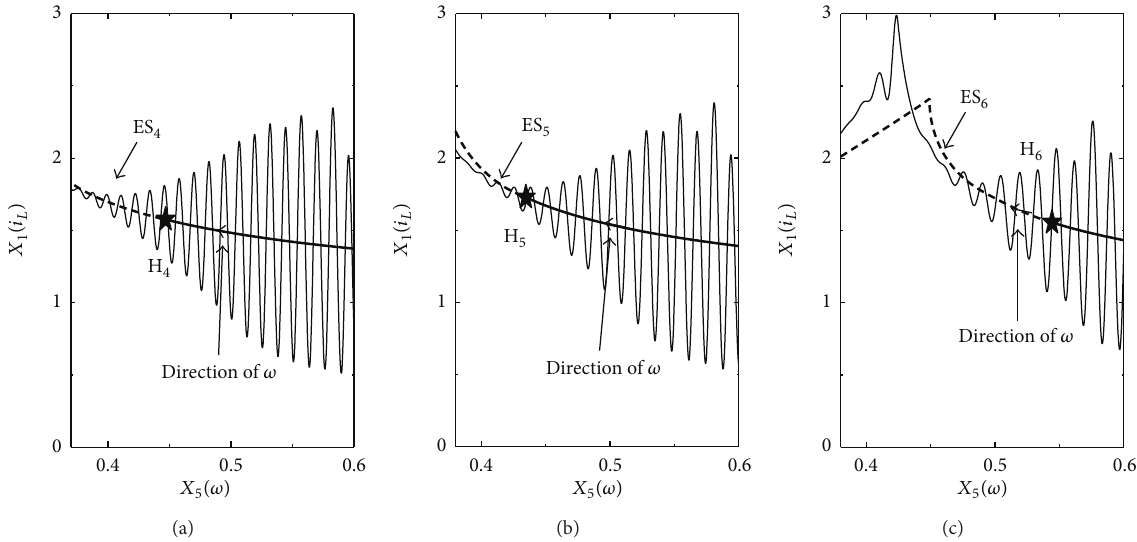
Figure 15: Stroboscopic phase trajectory of the full-system in 𝑋 5 (𝜔) − 𝑋 1 (𝑖 𝐿 ) as well as the transient fixed points curves at (a) 𝐽 󸀠 = 0.5 ⋅ 𝐽 , (b) 𝐽 󸀠 = 0.25 ⋅ 𝐽 , and (c) 𝐽 󸀠 = 0.1 ⋅ 𝐽 . H 4 , H 5 , and H 6 -Hopf bifurcation point.